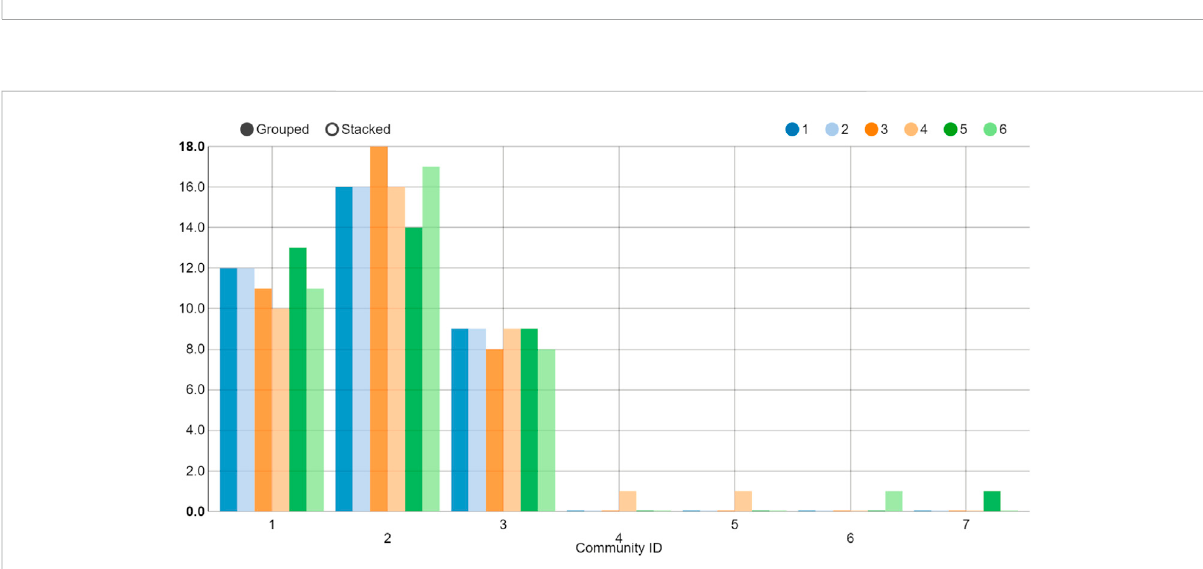
FIGURE 13 QuantitystatisticsineachcommunityatthebeginningoftheEuropeansubprimemortgagecrisis.ThehorizontalaxismeanstheCommunityID. The vertical axis indicates quantities of each Community